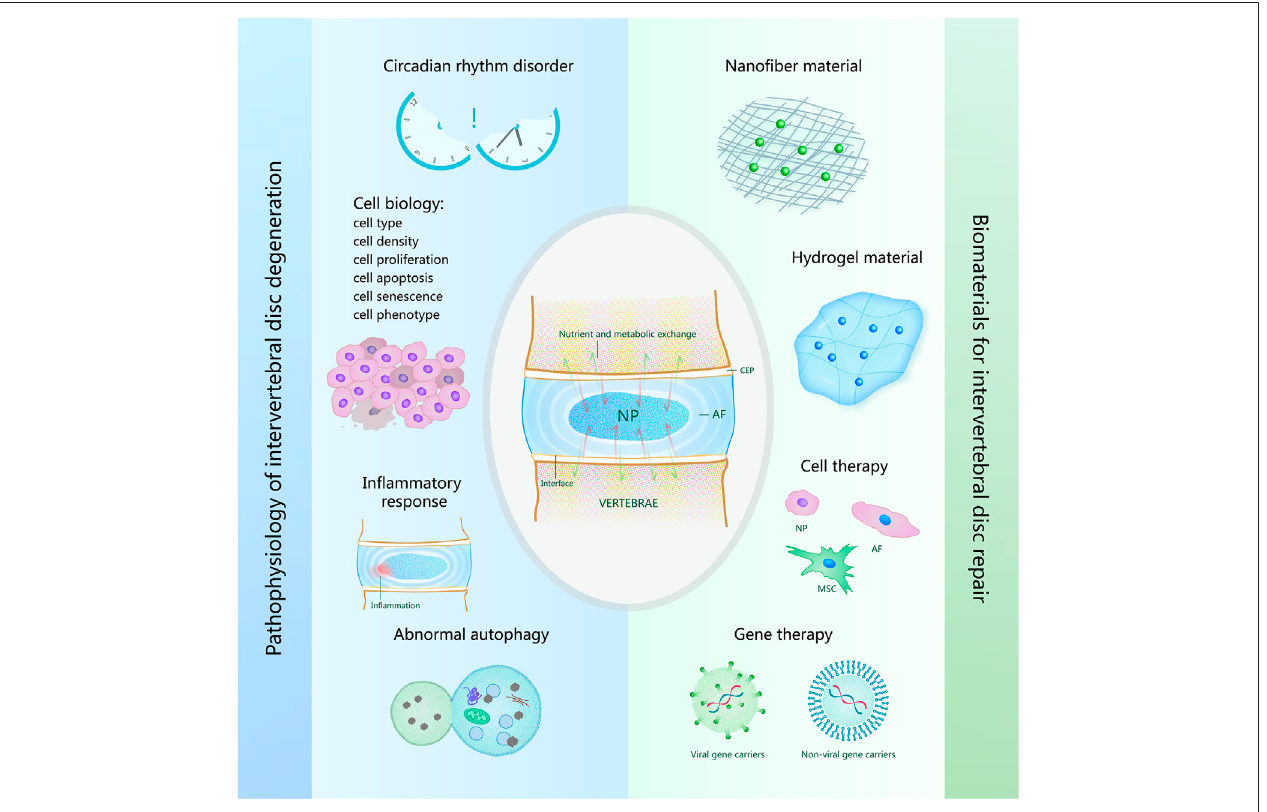
FIGURE 1 | Overview of pathophysiology of intervertebral disk degeneration and biomaterials for intervertebral disk repair. The pathophysiological causes of intervertebral disk degeneration shown on the left of the fi gure include circadian rhythm disorder, cell biology, in fl ammatory response, abnormal autophagy. The biomaterials for intervertebral disk repair shown on the right of the fi gure include nano fi ber material, hydrogel material, biomaterials for cell therapy and gene therapy.